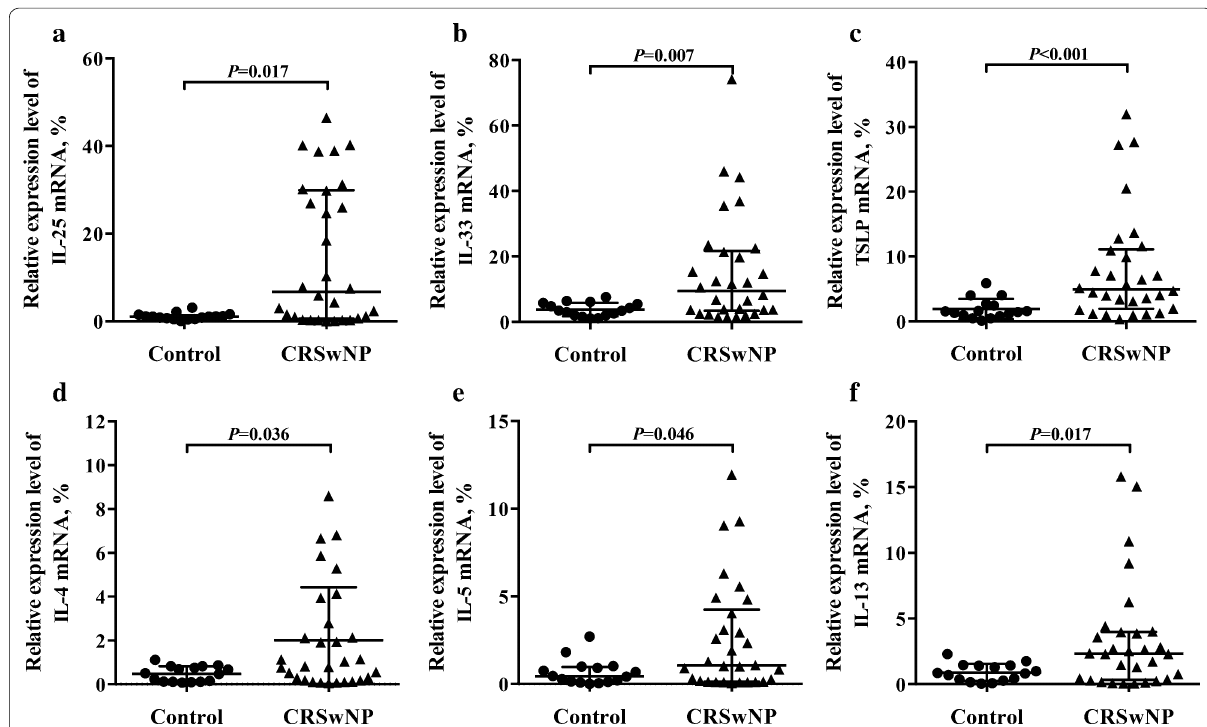
Fig. 1 Relative mRNA expression levels of cytokines in NP tissues. Epithelium‑derived cytokines IL‑25 ( a ), IL‑33 ( b ) and TSLP ( c ); Th2 cytokines IL‑4 ( d ), IL‑5 ( e ) and IL‑13 ( f ) were measured by quantitative RT‑PCR. In control group, n median with